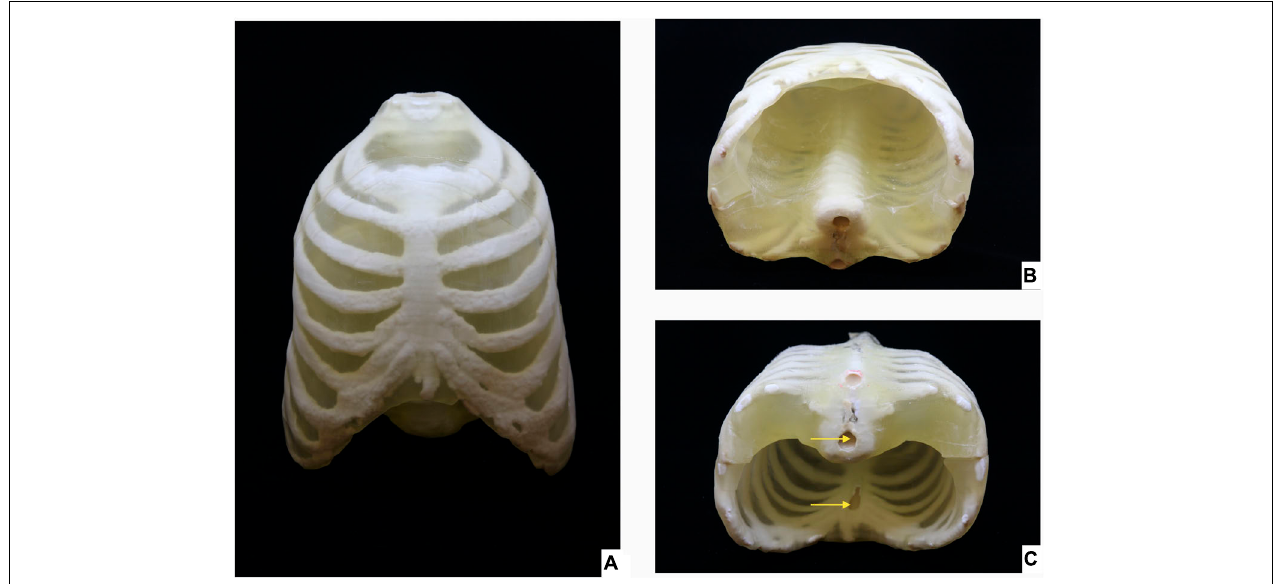
FIGURE 5 | 3D Printed thorax phantom. Thorax phantom consisting of the skeletal integument embedded in the transparent 3D printed body (A) Ventral view, (B) Caudal view of thorax phantom in supine position, (C) Caudal view of thorax phantom is prone position showing inlets (indicated by yellow arrows) for filling the radiopaque amalgamate in the sternum and ventral vertebral